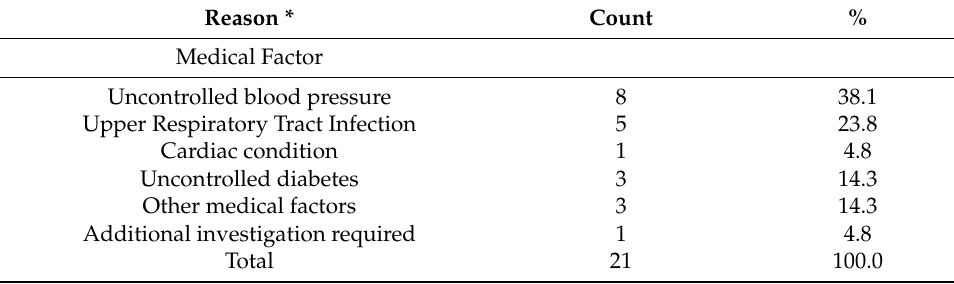
Table 4. Reasons for cataract surgery rescheduling for public